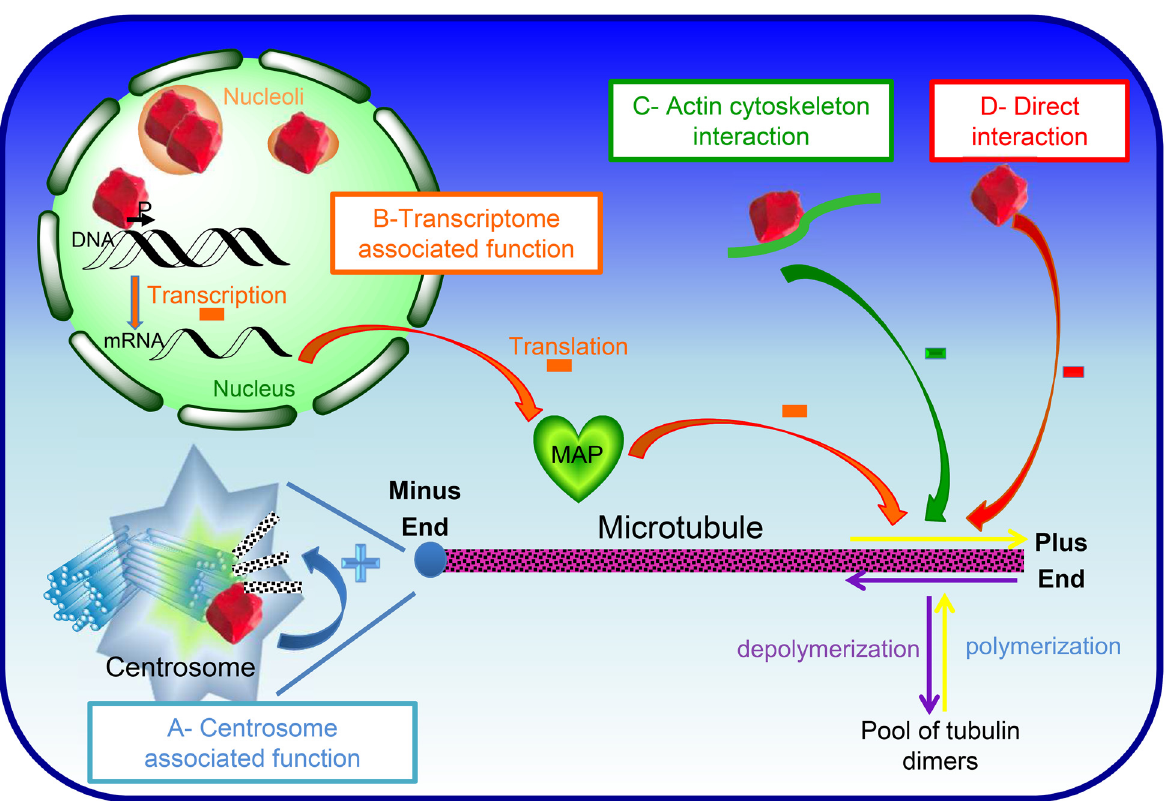
Fig 8. Nucleolin can affect microtubules stability through multiple pathways. Based on previous studies and our unpublished observations, four hypotheses can be drawn to explain nucleolin ’ s role on microtubule dynamics, simplified in the current scheme by polymerization and depolymerization arrows (respectively in purple and yellow) at the Minus and plus Ends. The first hypothesis derives from nucleolin ’ s role on centrosome function (A-centrosome associated function, in blue). Indeed, nucleolin (in red) localizes at the mature centriole, interacting with ninein and γ TuRC, where it is involved in microtubule nucleation and anchoring [15]. The second hypothesis is based on the control of RNAP II gene transcription (B- transcriptome associated function, in orange), which is regulated by nucleolin binding to a specific gene regulating element (our unpublished results). The third hypothesis is through binding to microtubule associated proteins or with actin cytoskeleton, known to interact with microtubule (C-Actin cytoskeleton interaction, in green). The fourth hypothesis is that nucleolin could directly interact with microtubules (D- Direct interaction, in red), thereby resulting in slower and longer- lasting polymerizing